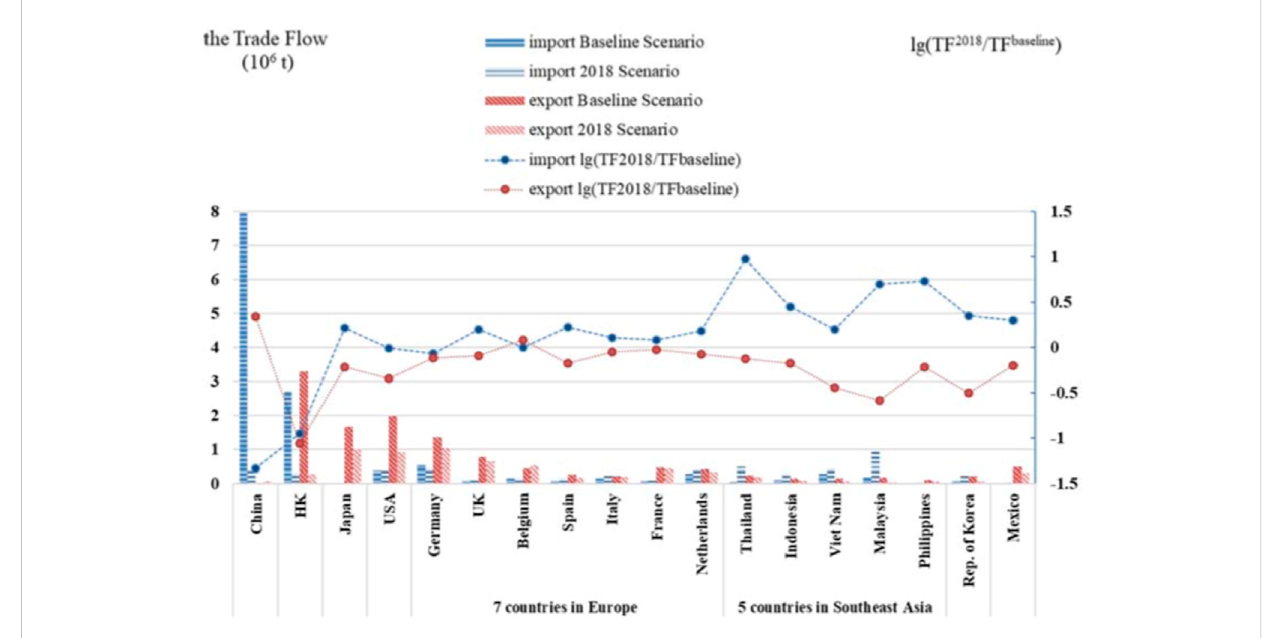
FIGURE 6 Changes in import and export fl ows after the ban (Wen et al., 2021).